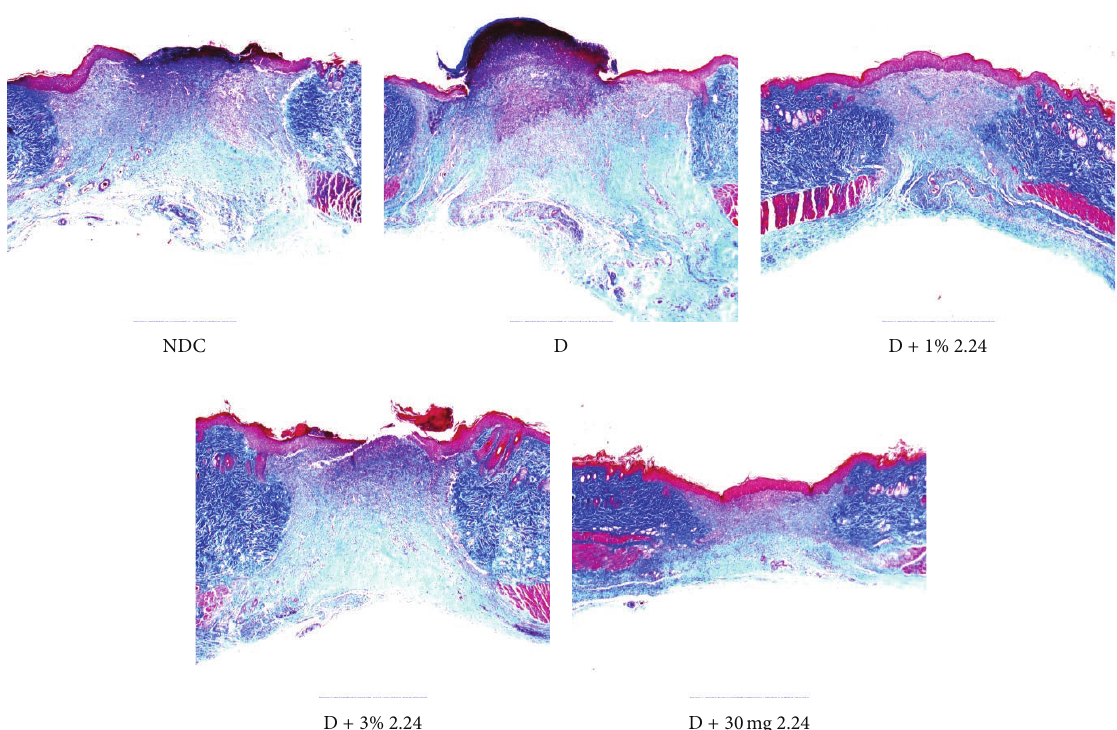
Figure 5: Masson’s Trichrome staining of collagen (blue-green) in the healing dermis of the NDC and D groups indicates that (1) diabetes delays healing of the subepithelial connective tissue and (2) 1% CMC2.24 topically applied is more effective than the other treatments in helping “normalize” this aspect of